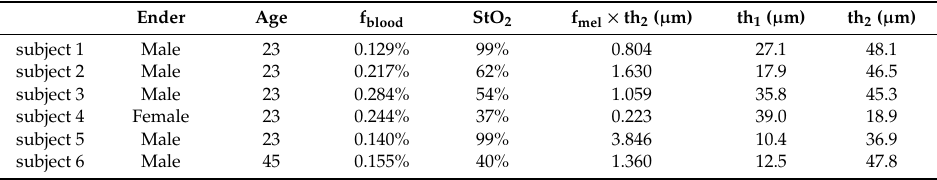
Table 3. Extracted geometric and optical parameters of the in-vivo inner forearm of five healthy volunteers.